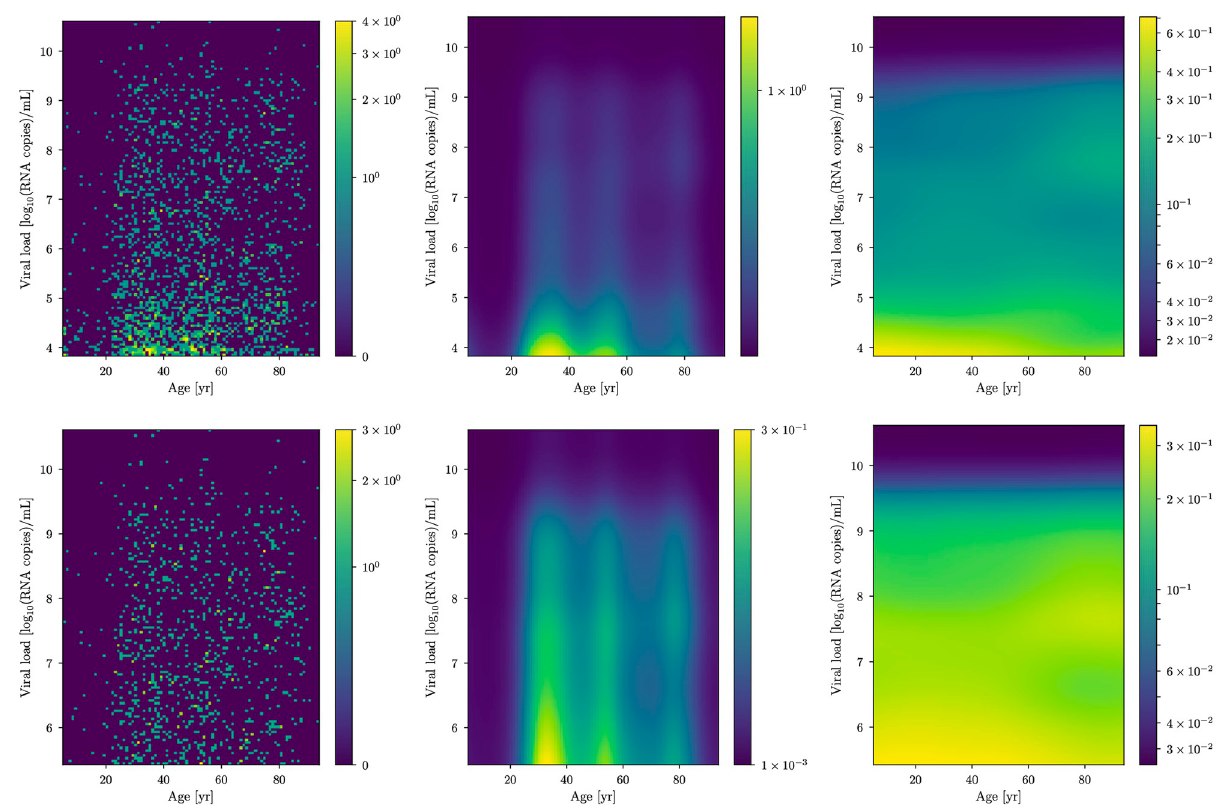
Fig 3. Cobas dataset analysis. Left: The cobas dataset. Middle: the reconstructed density distribution % ( x , y ) as a function of the age ( x ) and the viral load ( y ) in a logarithmic coloring scheme. Right: The 2D conditional probability distribution p ( y | x ) of the viral load (Eq 9) obtained by fitting the model. The data and the results of the analysis are shown for two different data-filtering thresholds y min (top) and y 0